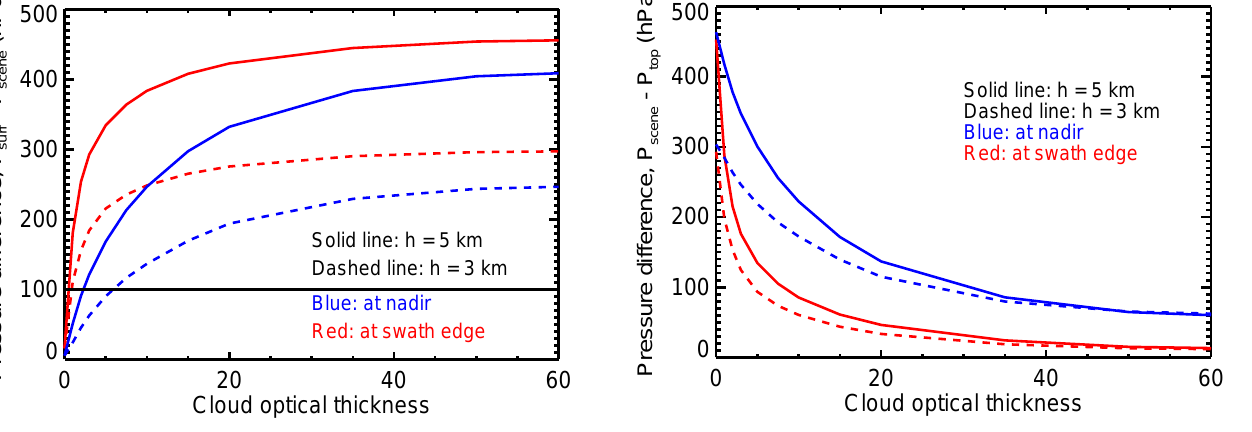
Fig. 3. As in Fig. 2 but for cloud-top pressure difference, P scene − P top . Table 1. Latitude (Lat.), longitude (Long.), solar zenith angle ( θ 0 ), viewing zenith angle ( θ ), relative azimuth angle ( φ ), and total cloud optical thickness ( τ ) of CloudSat profiles used for Jacobian compu-